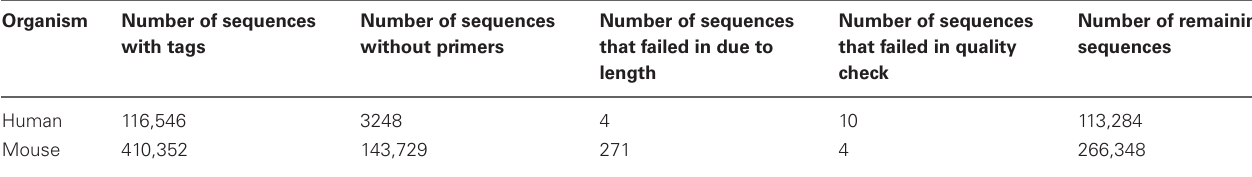
Table 3 | A summary of the Ig-HTS-Cleaner results: human and mouse data sets of 500K sequences together. Organism Number of